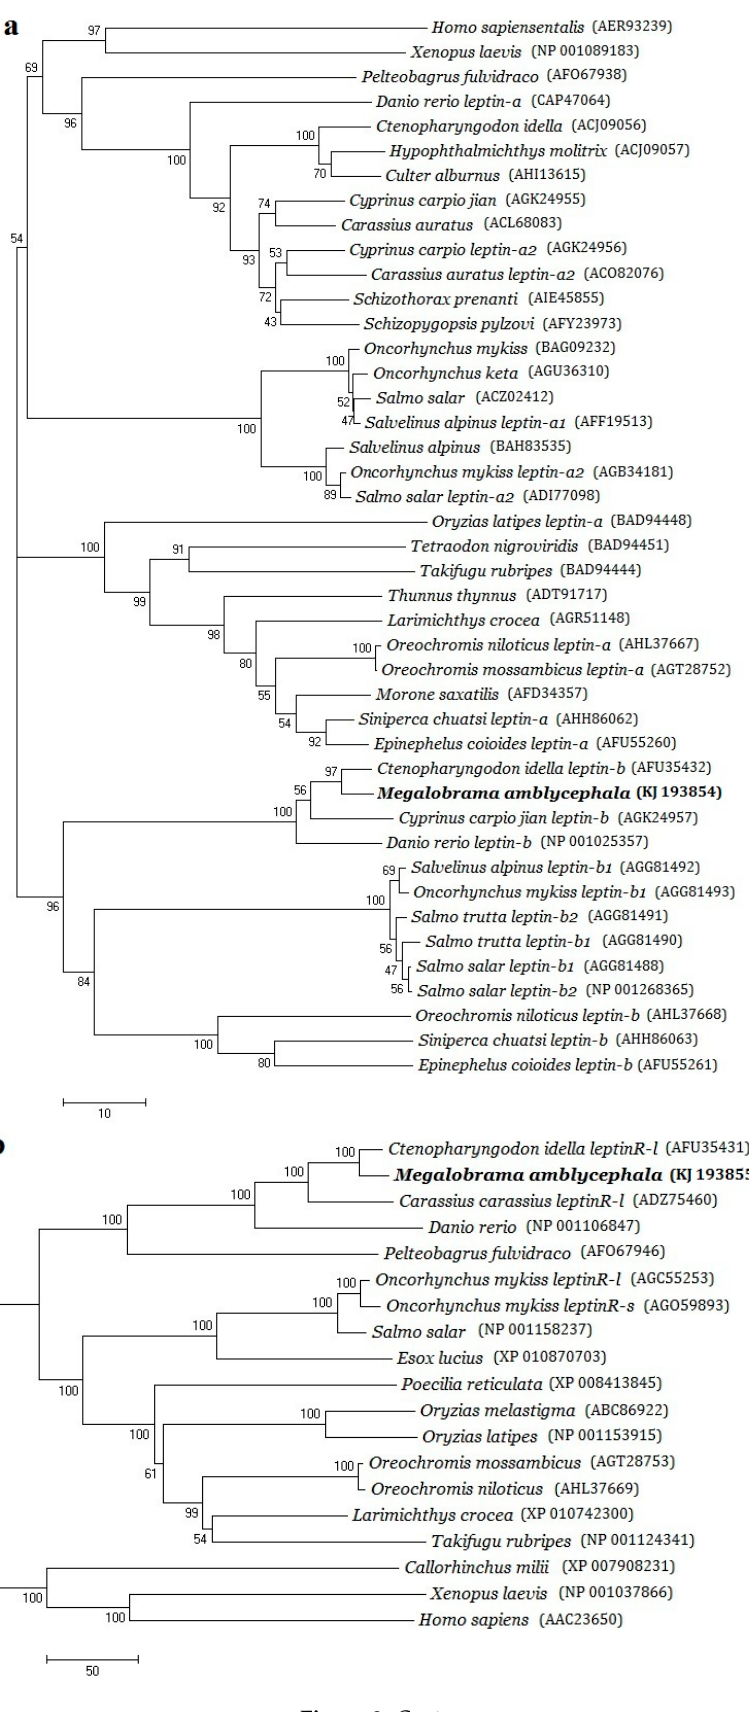
Figure 3. Cont. Figure 3.